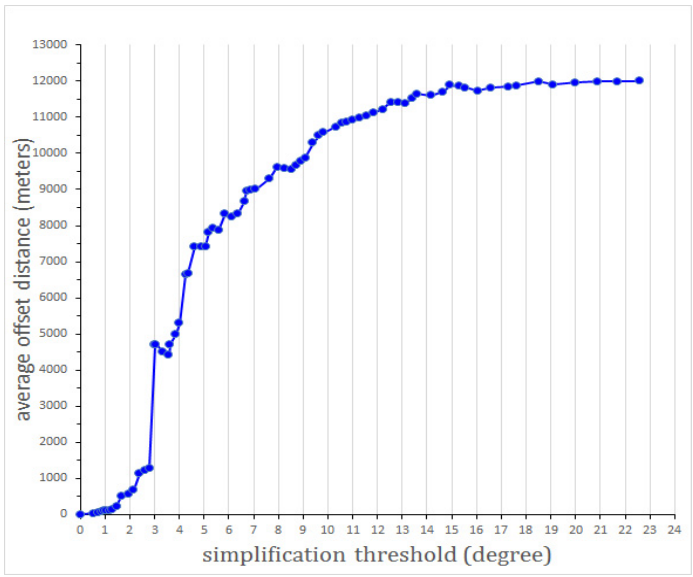
Figure 5. The curve of the average offset distances varying with simplification thresholds.